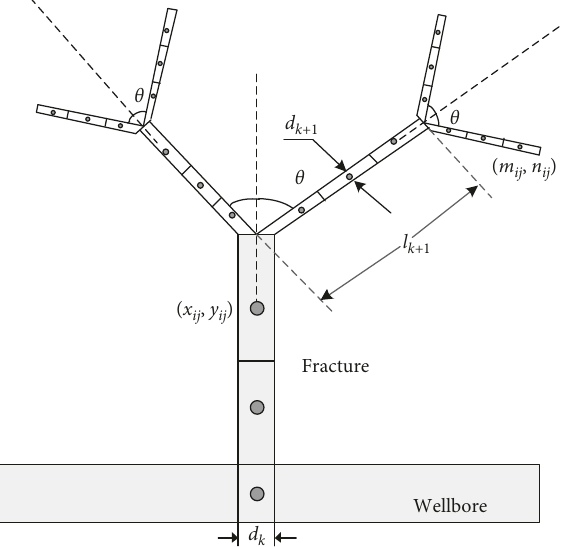
Figure 2: Schematic of a fractal bifurcation tree fracture network physical